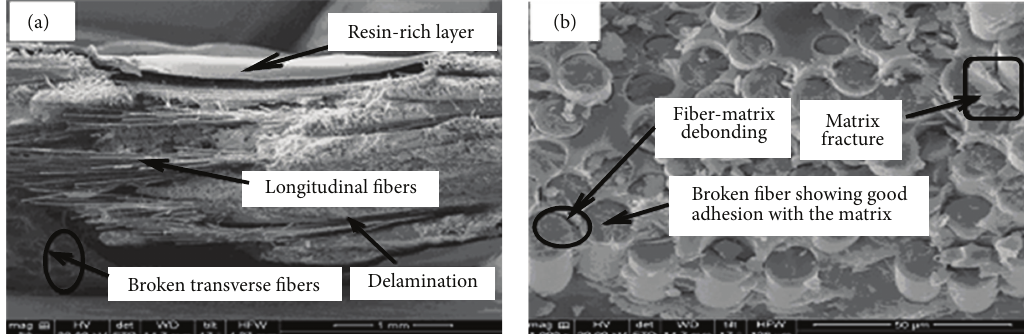
Figure 9: SEM pictures of tensile fractured surfaces of 7.5% SiO 2 filled G-E, (a) longitudinal direction, (b) transverse direction.